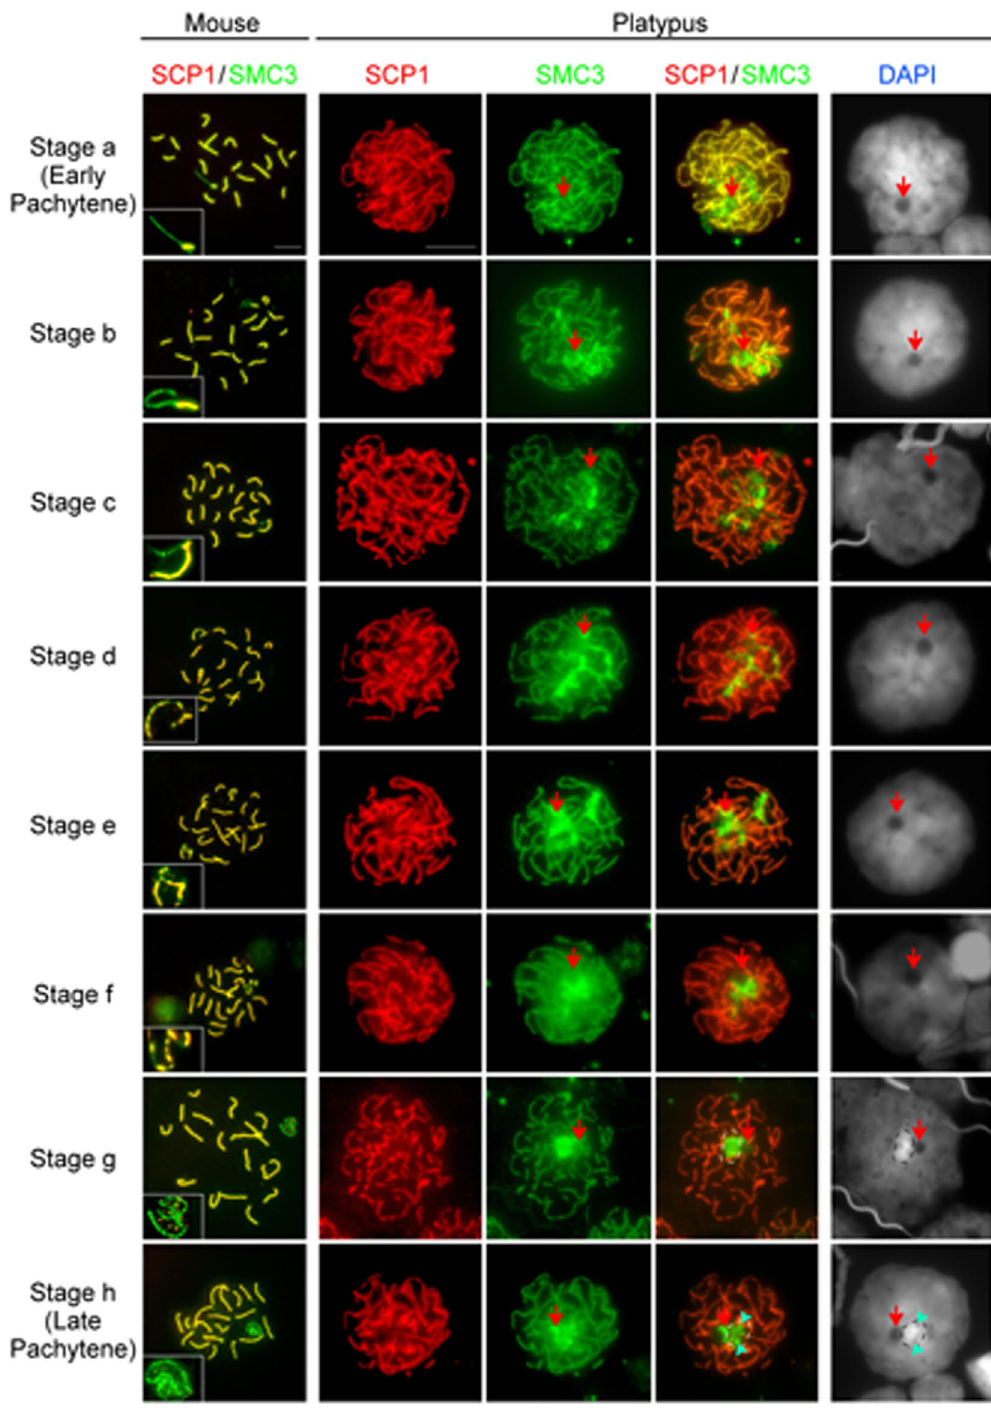
Figure 5. Substages of mouse and pachytene cells based on their sex chromosome configuration and synaptonemal complex length. There are eight distinct mouse sex chromosome patterns for each stage (insets). In all stages the platypus sex chromosome chain is attached to a large nucleolus (red arrow). In platypus stage g and h nuclei, the region of significant cohesin accumulation colocalises with a DAPI intense region (black/white dashed surround). In platypus late pachytene, protein bodies are observed (light blue arrowheads). Note that mouse and platypus stages are provided for comparison and may not represent exactly equivalent stages. Scale bar = 10 µ